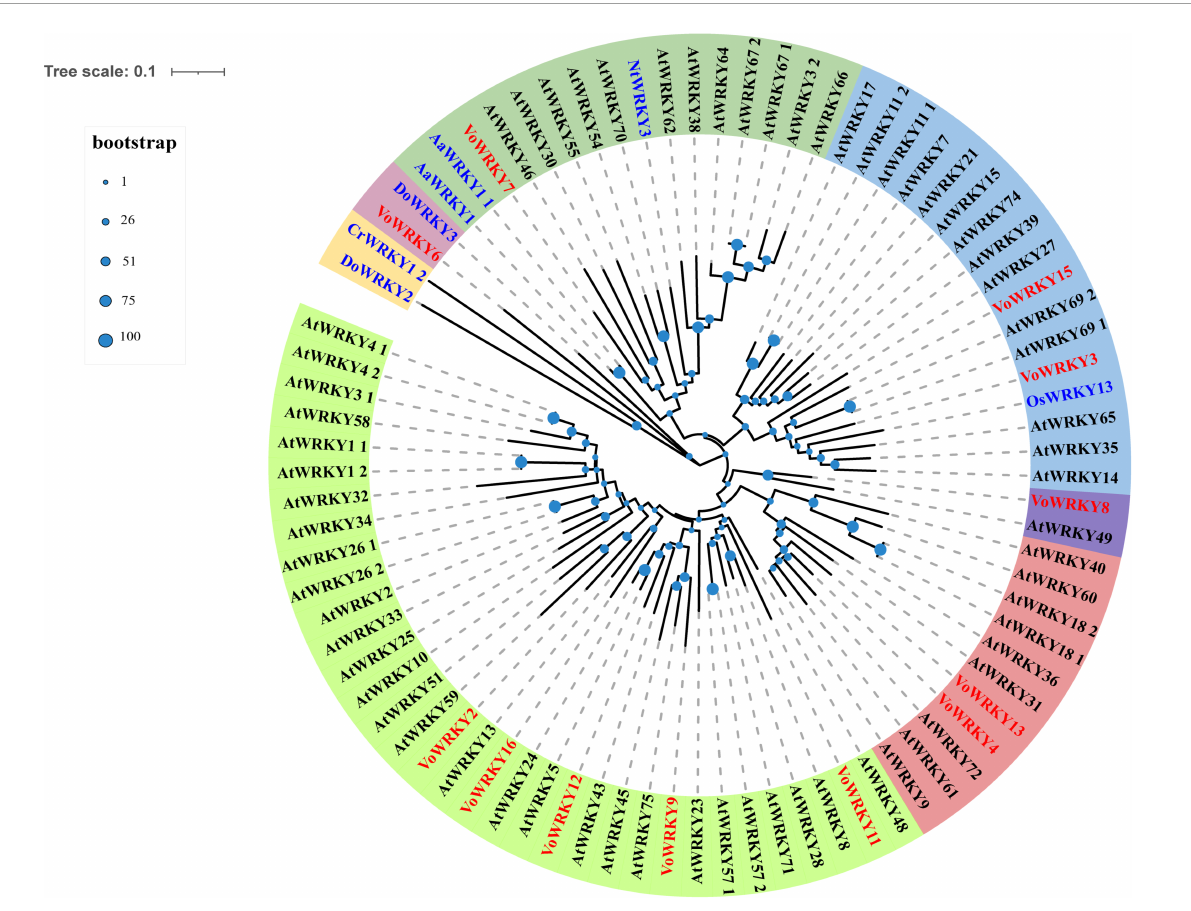
FIGURE11 Phylogenetic tree of WRKY transcription factors in Verbena officinalis. Red font is Verbena officinalis TFs, black font is Arabidopsis thaliana transcription factor, and blue font is transcription factor of other species. The size of the blue node represents the bootstrap value.